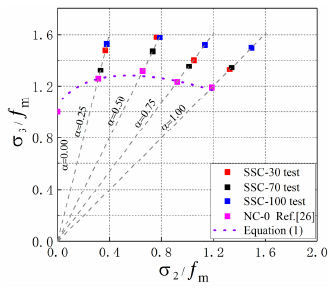
Table 4. The fitting results of failure criterion model for SSC.